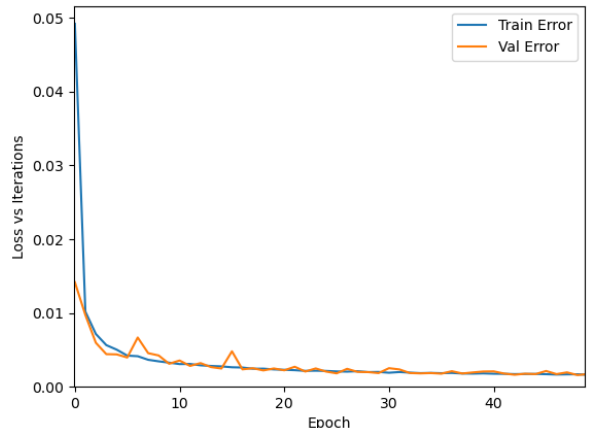
Figure 5. Neural Network Training